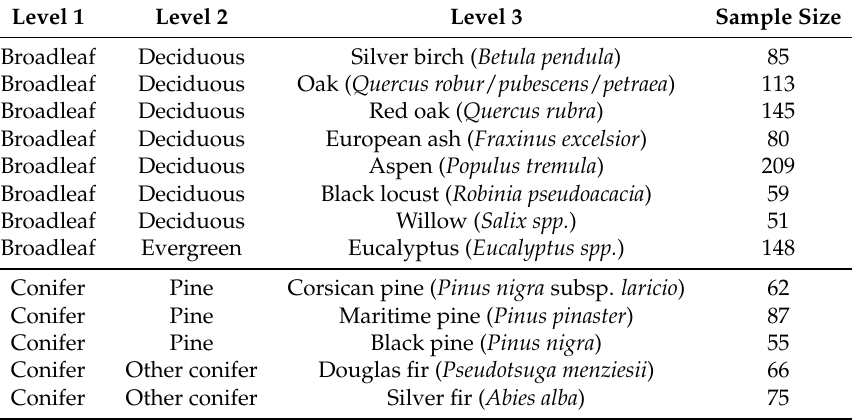
Table 1. Class hierarchy composed of three levels with the sample size of collected reference data (in pixels ; n = 1235) for all the tree species. Each sample represents the pixel at the center of nine contiguous pixels of the same species. Level 1 Level 2 Level 3 Sample Size Broadleaf Deciduous Silver birch ( Betula pendula